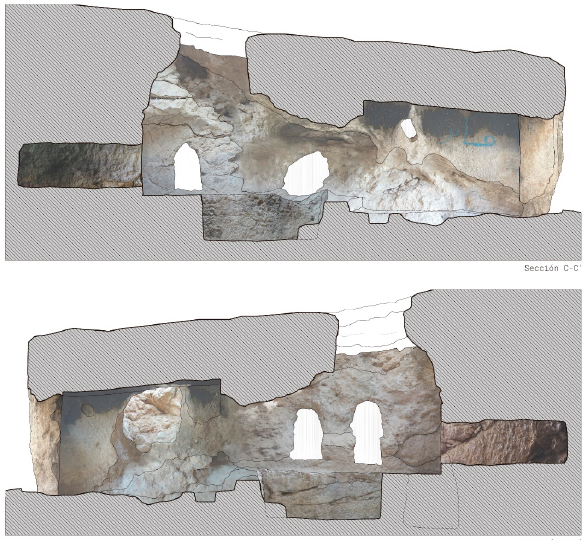
Figure 4. The vestibule: longitudinal sections of the space.